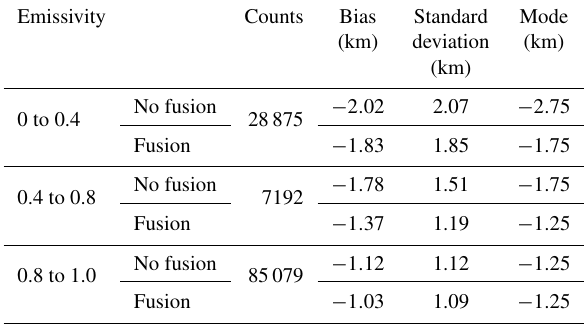
Table 5. Statistics of differences between NOAA-20 VIIRS cloud top retrieval and CALIPSO/CALIOP using 1 week of data in Jan- uary 2019, with and without the use of fusion channels for three emissivity